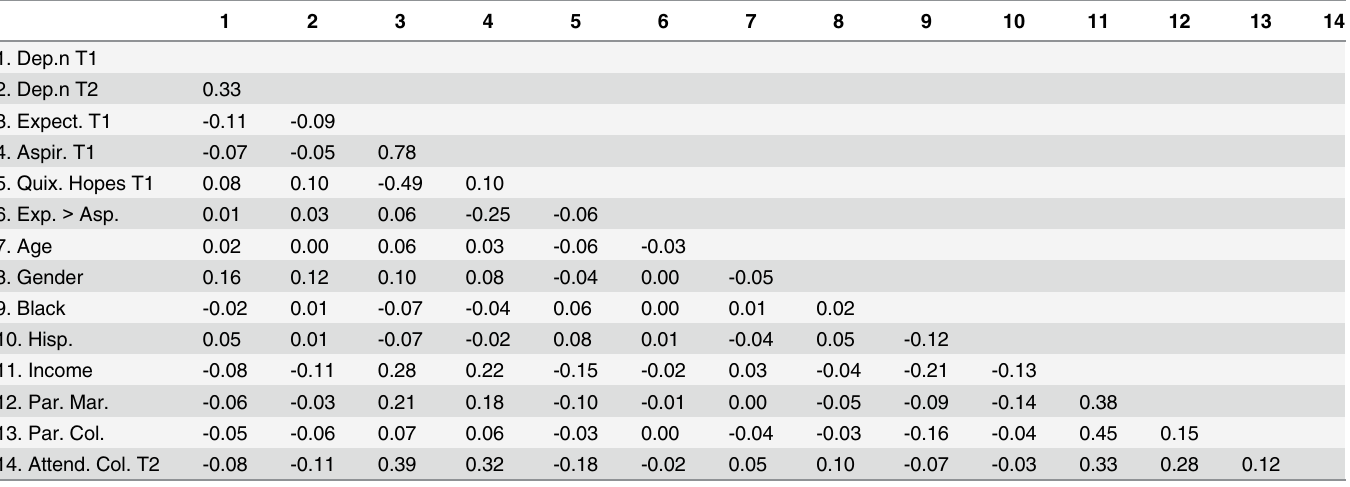
Table 6. Bivariate correlations between the variables in the model (Study 2, Time